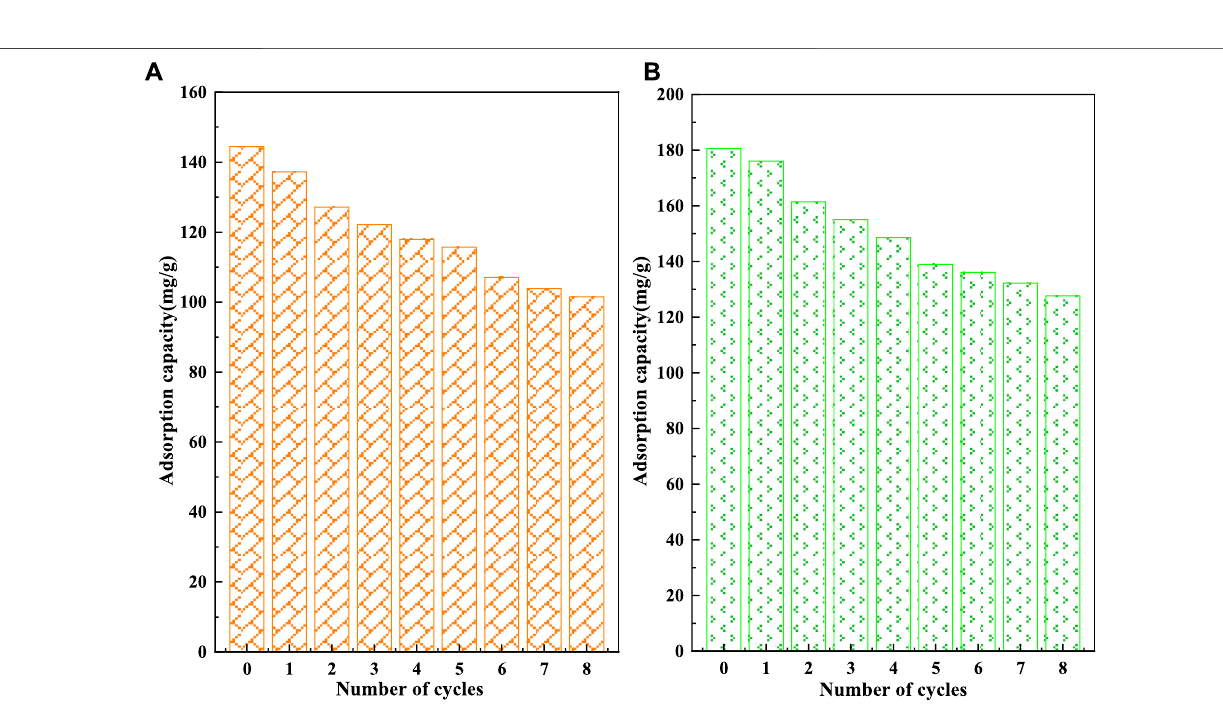
Frontiers in Environmental Science |